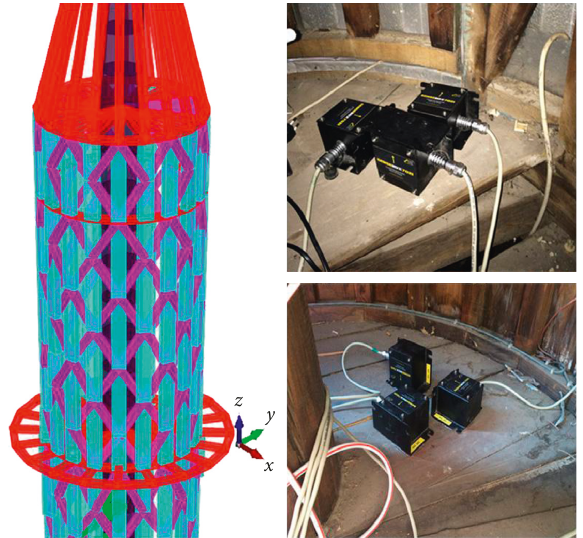
Figure 3: The sensors and their placements on the balcony